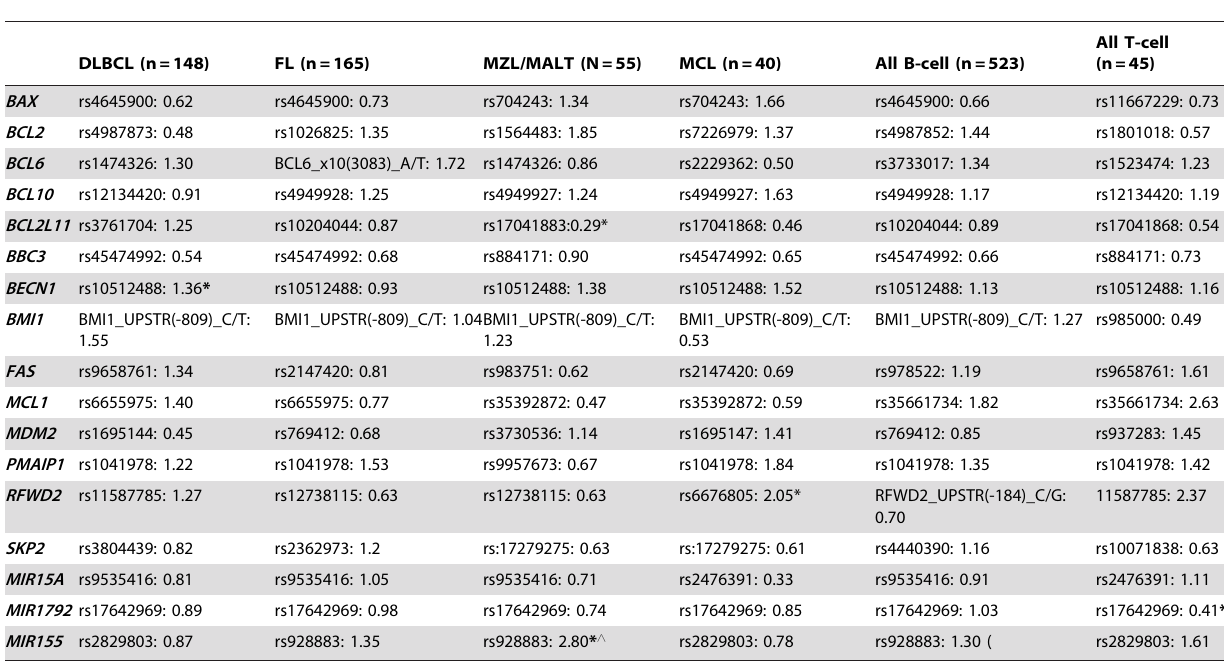
Table 3. Summary of results for the top-ranked SNP (ranked by p p ) in each gene in European-ancestry samples for the major